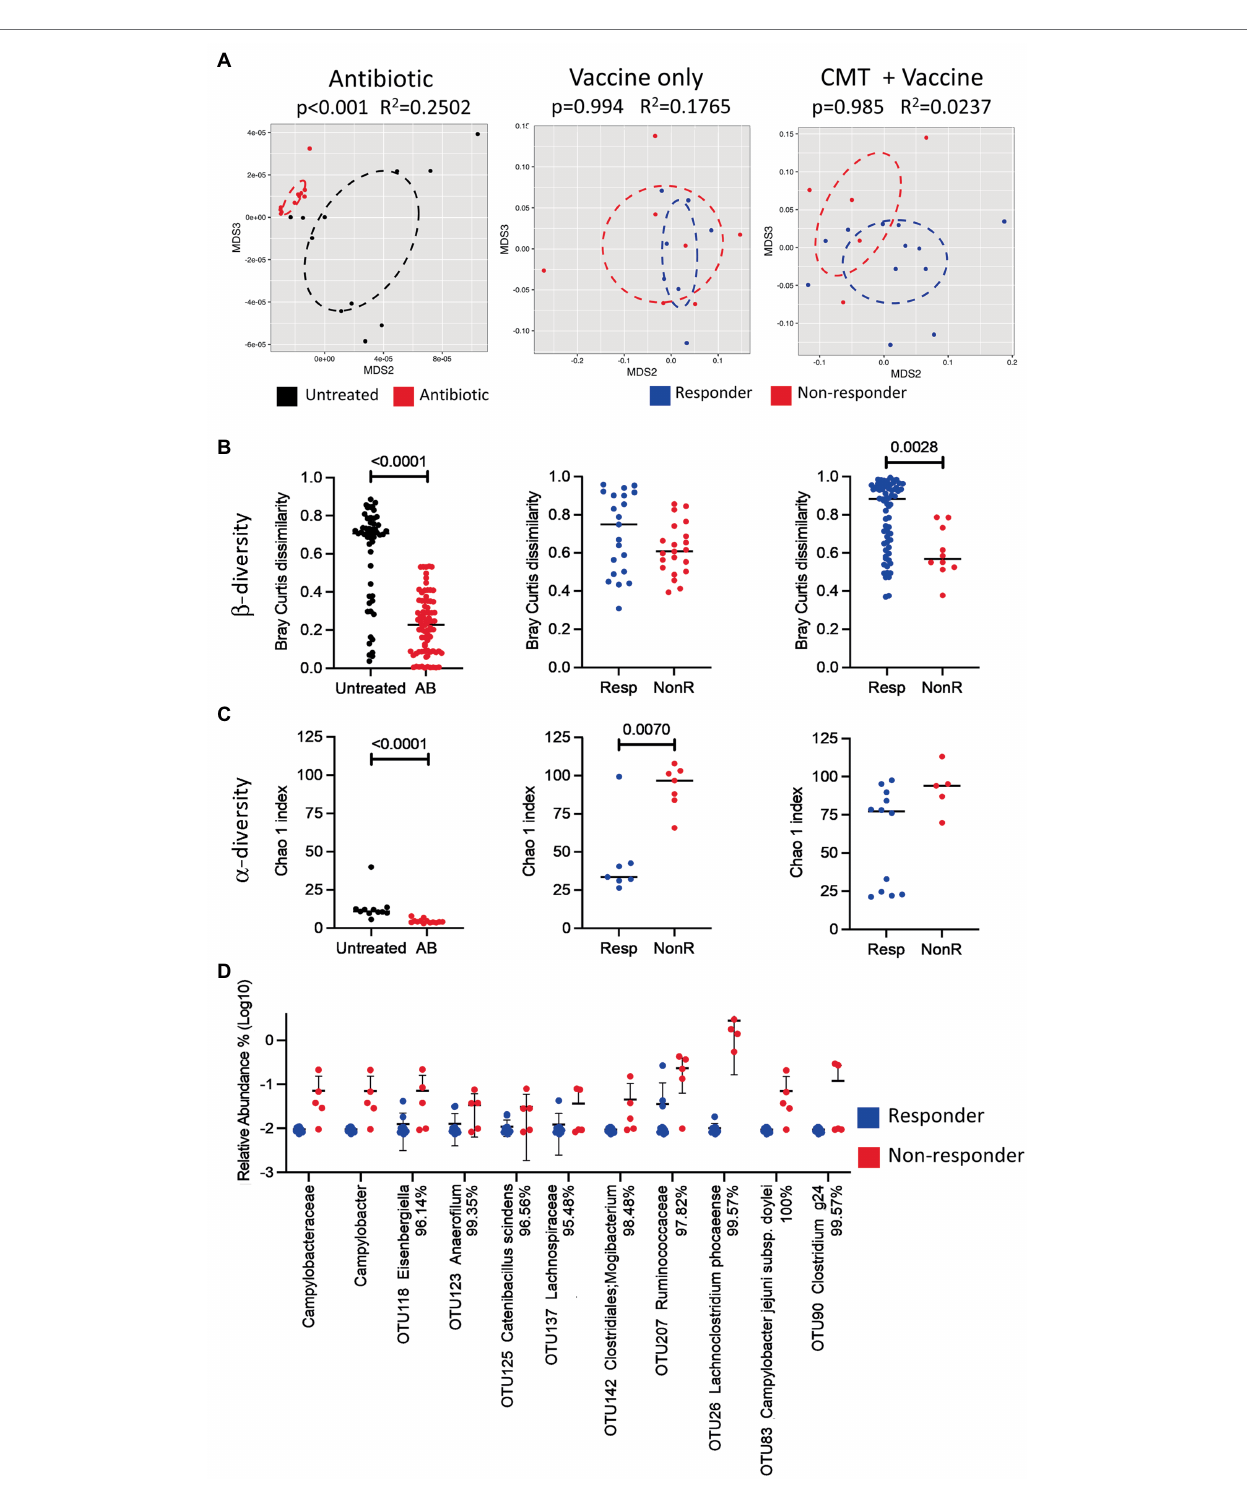
FIGURE 5 | Effect of antibiotic treatment, vaccine, and cecal microbiota transplant on microbial diversity. (A) NMDS plots analyzed by PERMANOVA test; (B) scatter dot plots of Bray-Curtis dissimilarity analyzed by Mann-Whitney test as a measurement of beta diversity; and (C) scatter dot plots of Chao 1 indexes as a measure of alpha diversity for untreated and antibiotic-treated groups (left), and between responders and non-responders for vaccinated chickens treated with (right) or without (middle) cecal microbiota transplant. OTUs were used for all diversity analyses. Lines represent median values. (D) Scatter dot plot of statistically significant differences in taxa between responders and non-responders analyzed by multiple t -tests. Percentages beside the names refer to percent identity for each taxon. Lines represent mean and standard deviation. Significance was established at p < 0.05. CMT, cecal microbiota transplant; AB, antibiotic; Resp, responder; and NonR,